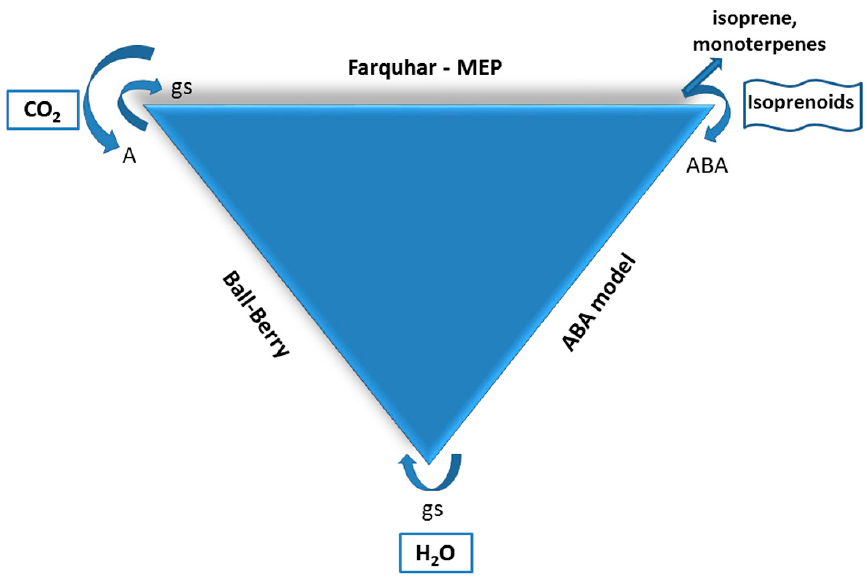
Figure 5. Simplified diagram showing proposed model interactions between a Ball–Berry (stomatal conductance), Farquhar–MEP (photosynthesis-isoprenoid), and isoprenoid emissions and ABA (stomatal conductance) models.